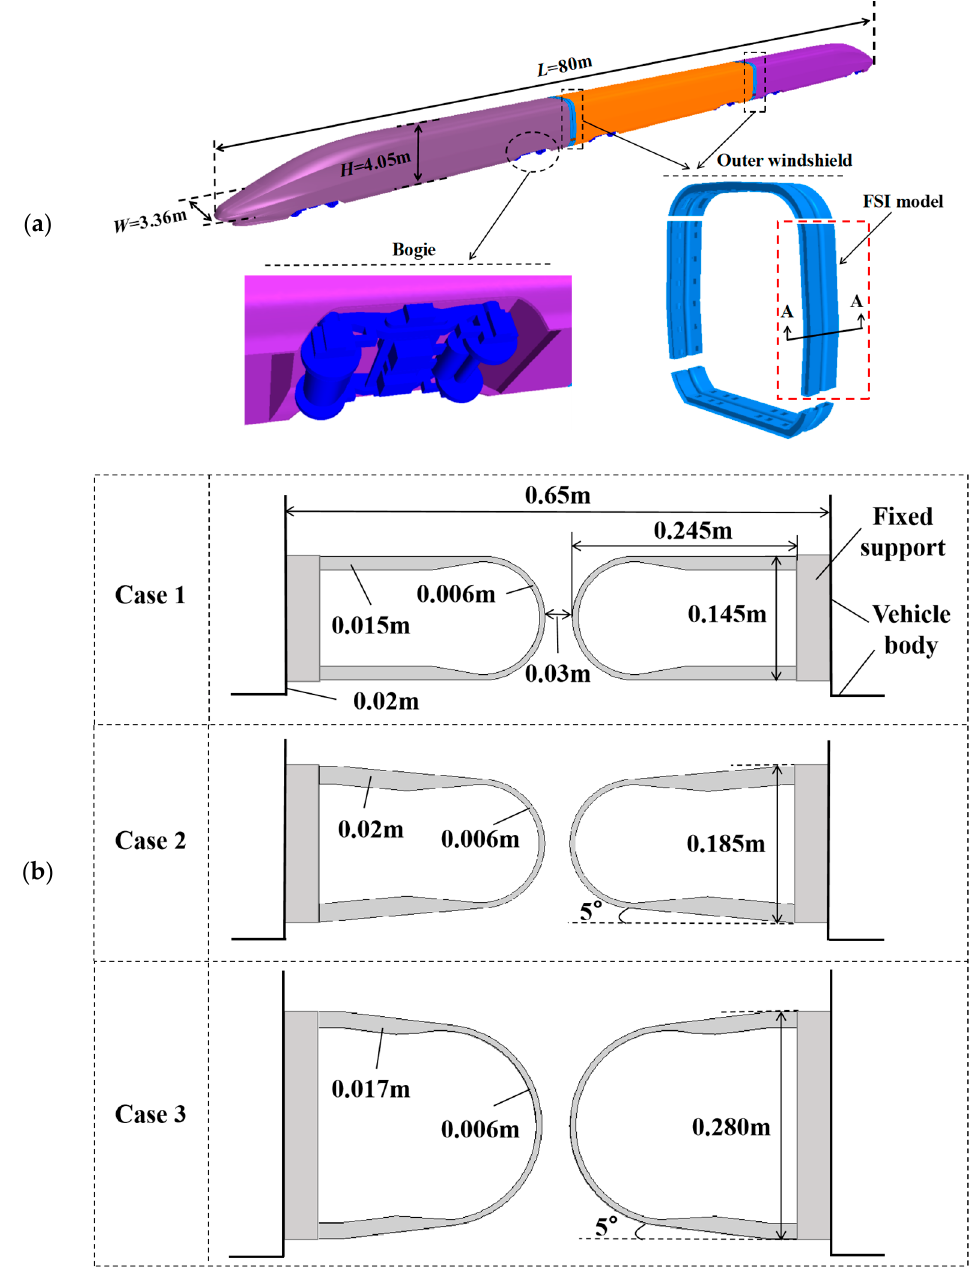
Figure 2. Computational model: ( a ) train model, ( b ) geometric outline at A–A section of different outer windshield schemes.